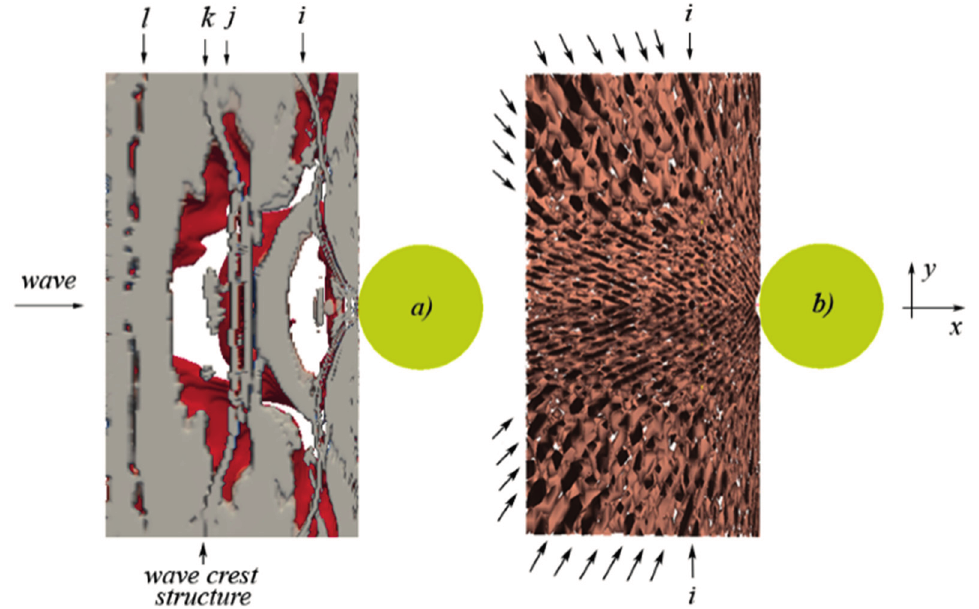
Figure 27. Flow-field representation at 0.750 T = ( T is wave period), top view (free-surface level): ( a ) flow-structures (colored with spanwise vorticity); ( b ) surfaces of constant x- velocity from reconstruction based on the three most energetic KL